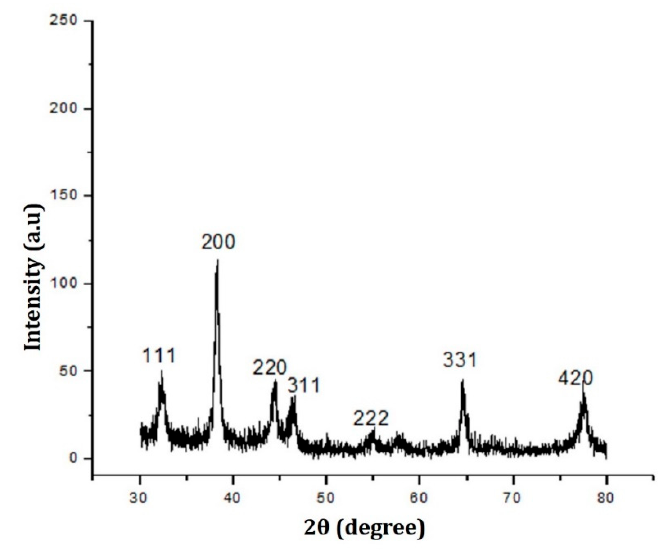
Figure 4. XRD diffractogram of Talaromyces funiculosus –AgNPs.